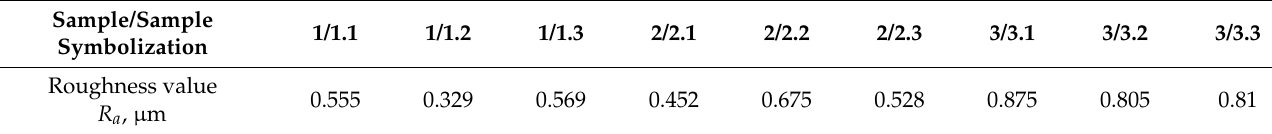
Table 3. Roughness values of the cast iron specimens.